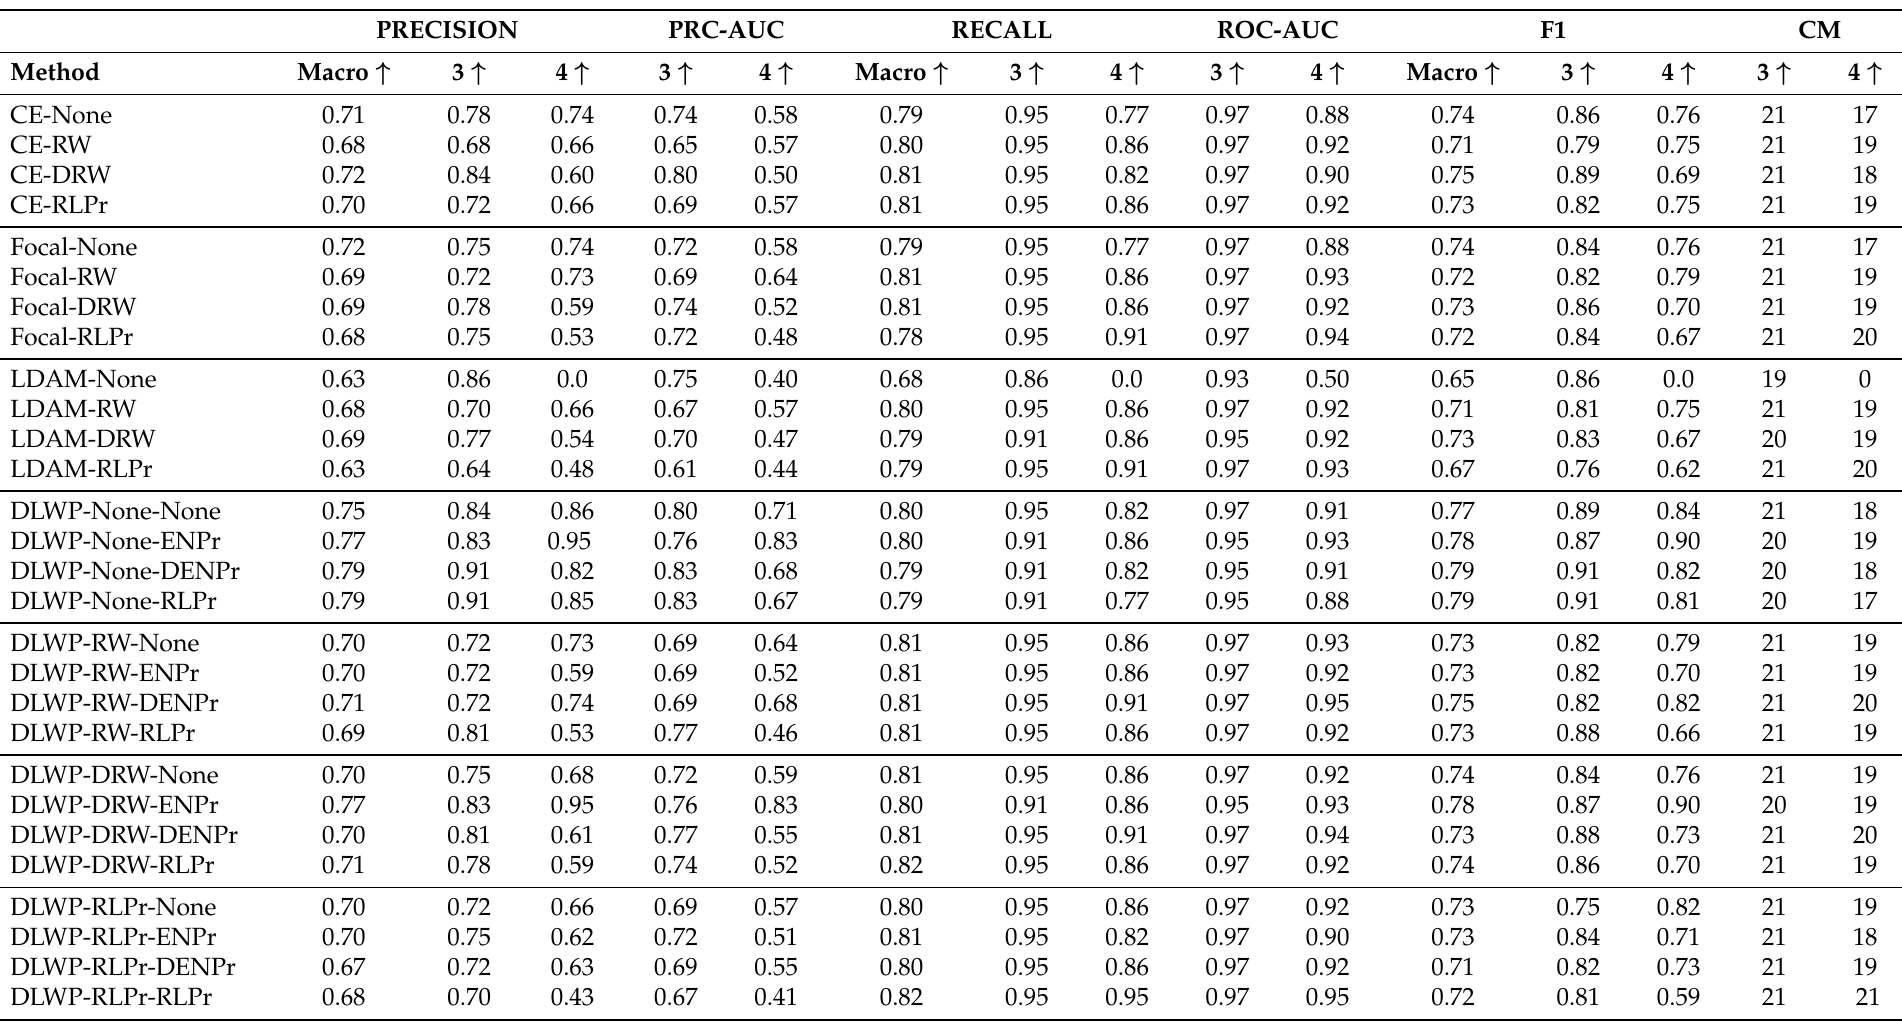
Table A2. Extended results from experiments on the Steel Plates Faults dataset. We consider the metrics Precision, PRC-AUC, Recall-Macro, ROC-AUC, F1, and CM (Confusion Matrix) leading diagonal non-normalized scores for Classes 3 and 4. Class 3 (Stains) and Class 4 (Dirtiness) represent the minority classes out of the 7 classes from the